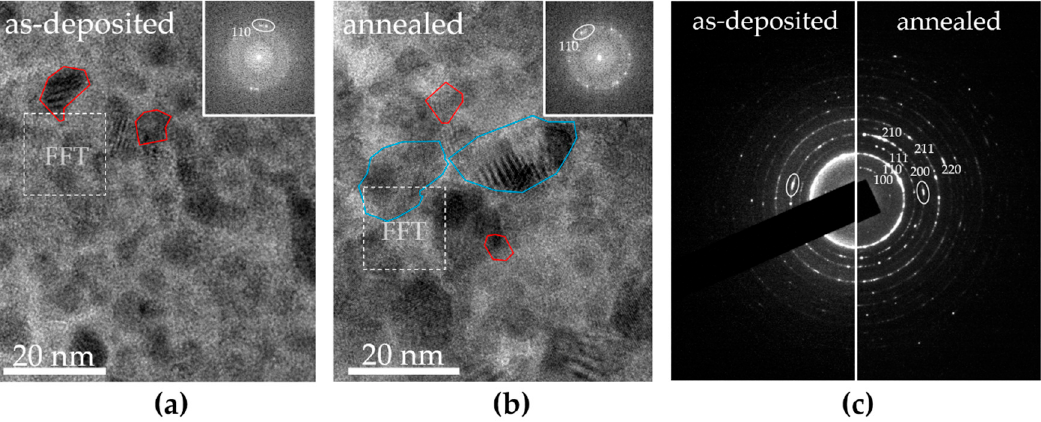
Figure 3. Transmission electron microscopy (TEM) images of grains in: ( a ) the as-deposited film with the FFT inset of the marked region; and ( b ) the annealed film (larger and smaller grains are circled in blue and red, respectively), with an inset of the FFT from the marked region. ( c ) Comparison of the SAED of both films. Circles mark reflections that are indicative of texturing. The Pm ͞ 3m space group was used to index the SAED pattern (PDF#01-074-4513).